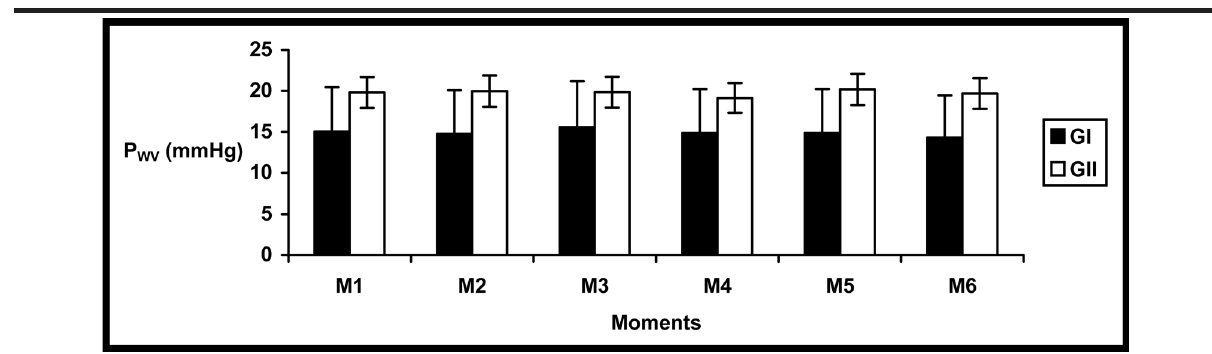
each moment in both experimental